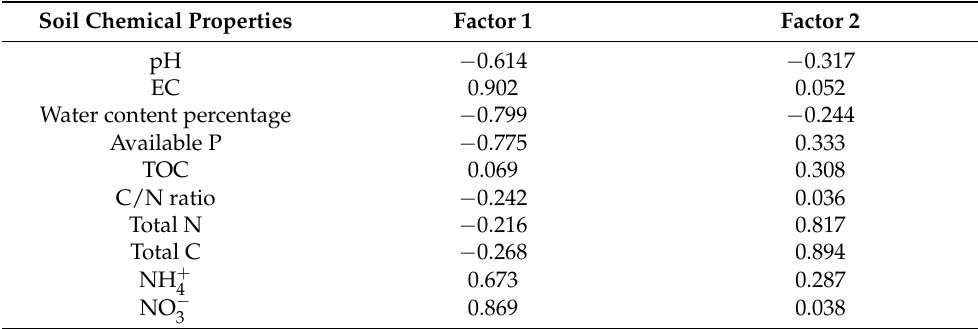
Table 2. Factor loadings of the first two main components of the PCA for variable soil parameters associated with nitrogen fertilizer application with and without